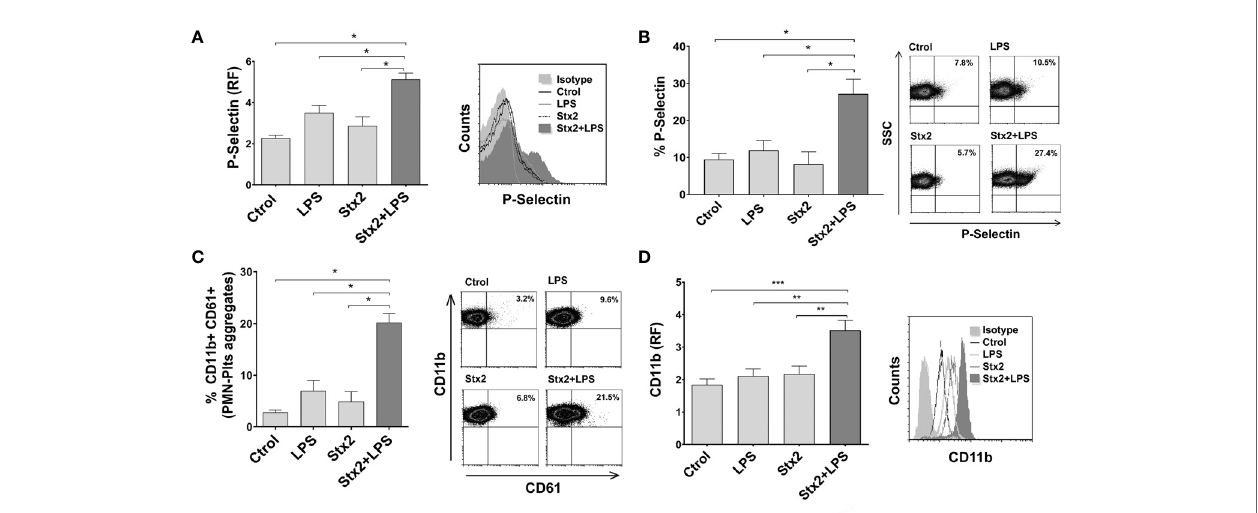
FIGURE 3 | Increased Plts activation, PMN – Plts mixed aggregates formation, and PMN activation after Plts stimulation with Stx2 and LPS. (A) Plts were left untreated (Ctrol) or treated with 20 ng ml − 1 Stx2 (Stx2) for 20 min before adding or not adding LPS (0.3 µg ml − 1 ) for another 20 min (LPS or Stx2+LPS). Expression of P-selectin was determined by fl ow cytometry, and results of P-selectin fl uorescence relative to isotype control (RF) are depicted. Histogram plots from one representative experiment are presented (right) (n = 3). (B) Percentage of P-selectin-positive Plts after treatment with the different stimuli. Representative dot plots are shown on the right (n = 3). (C) Treated Plts were washed to remove stimuli and then co-incubated with PMN for 10 min in a 1:50 PMN/Plts ratio. Cells were stained with PE-CD11b and FITC-CD61. The percentage of PMN – Plts mixed aggregates (CD11b+ CD61+) was analyzed by fl ow cytometry. Representative analysis of an independent experiment showing density plots is shown (right) (n = 3). (D) Treated Plts were washed and then co-incubated with PMN for 40 min in a 1:50 PMN/Plts ratio. CD11b expression was measured on PMN. Results are shown as the fl uorescence of CD11b relative to isotype control (RF). Histogram plots from one representative experiment are presented (right) (n = 7) (mean ± SEM). *p < 0.05; **p < 0.005; ***p <